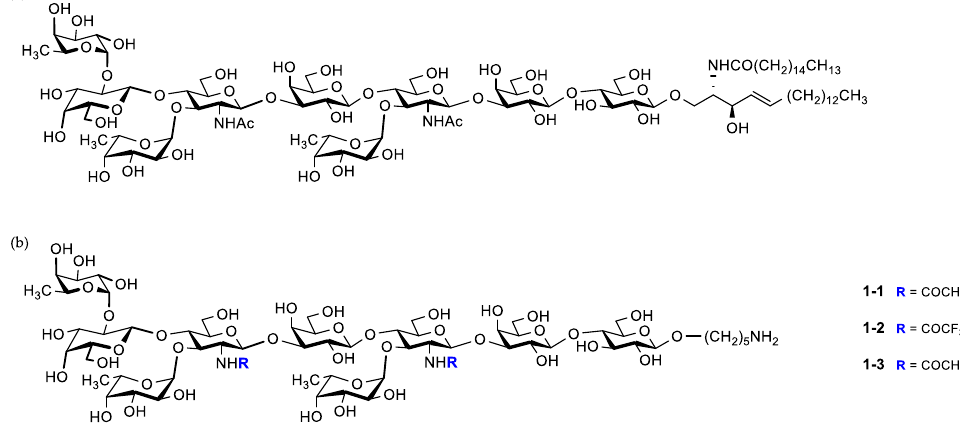
Figure 1. ( a ) Native KH-1 antigen; ( b ) fluorine-modified and unmodified KH-1 derivatives in this work.